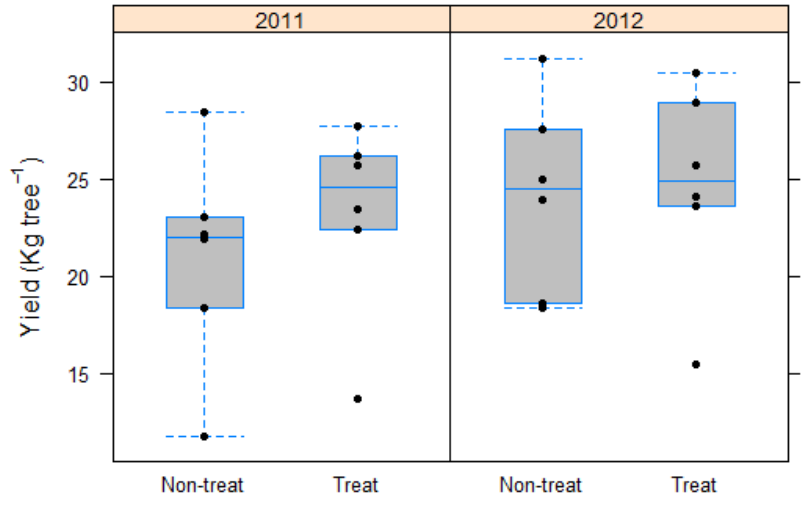
Figure 5. Box-whisker plots of yield of trees treated with fenbuconazole and the non-treated control in experiment 2 on ’Valencia’ sweet orange at Miraflores, Panama, in 2011 and